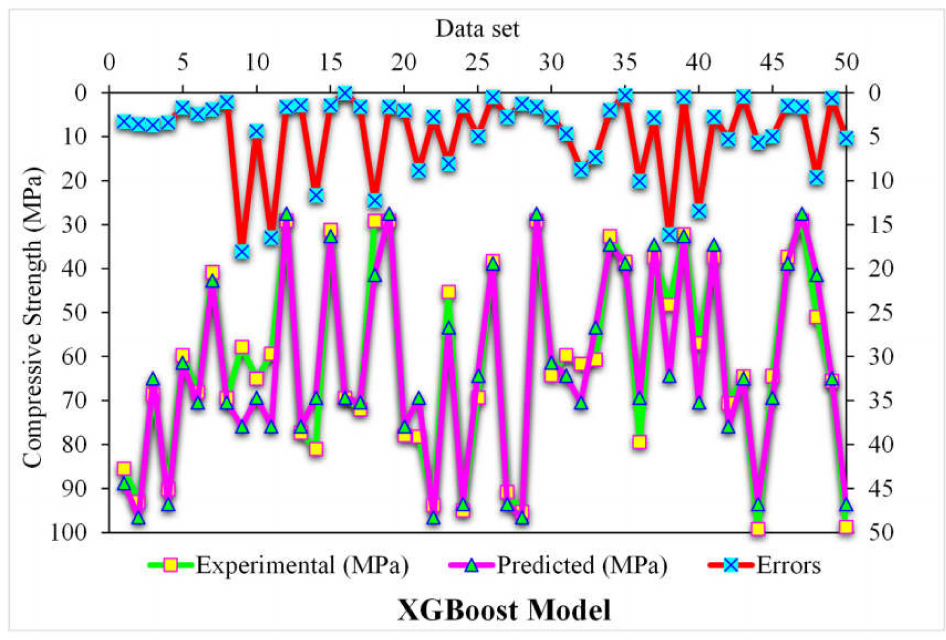
Figure 8. Experimental and XGBoost predicted values with errors.